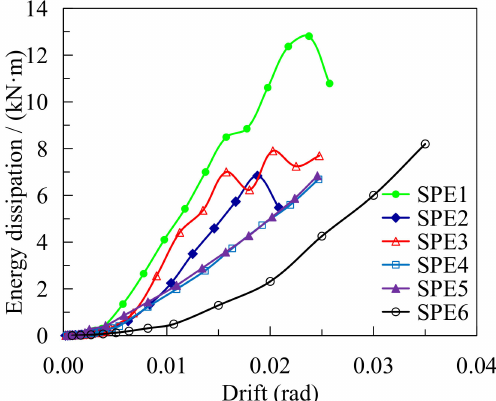
Figure 15. Energy dissipation